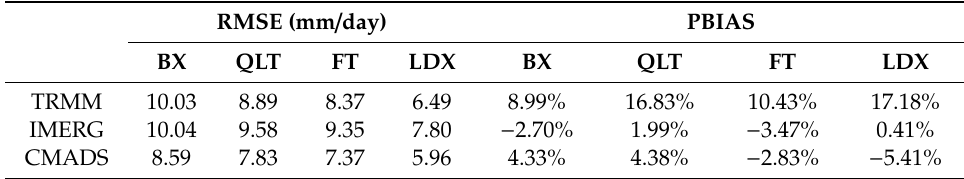
Table 3. The Root Mean Square Error (RMSE) and Percentage Bias (PBIAS) of the three products relative to the Gauged data in the four